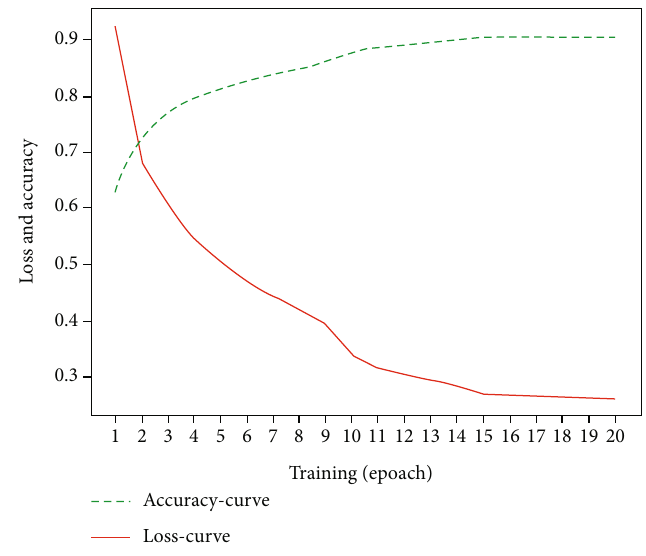
Figure 9: Loss curve and accuracy curve of model training. Table 3: Average information entropy record table.